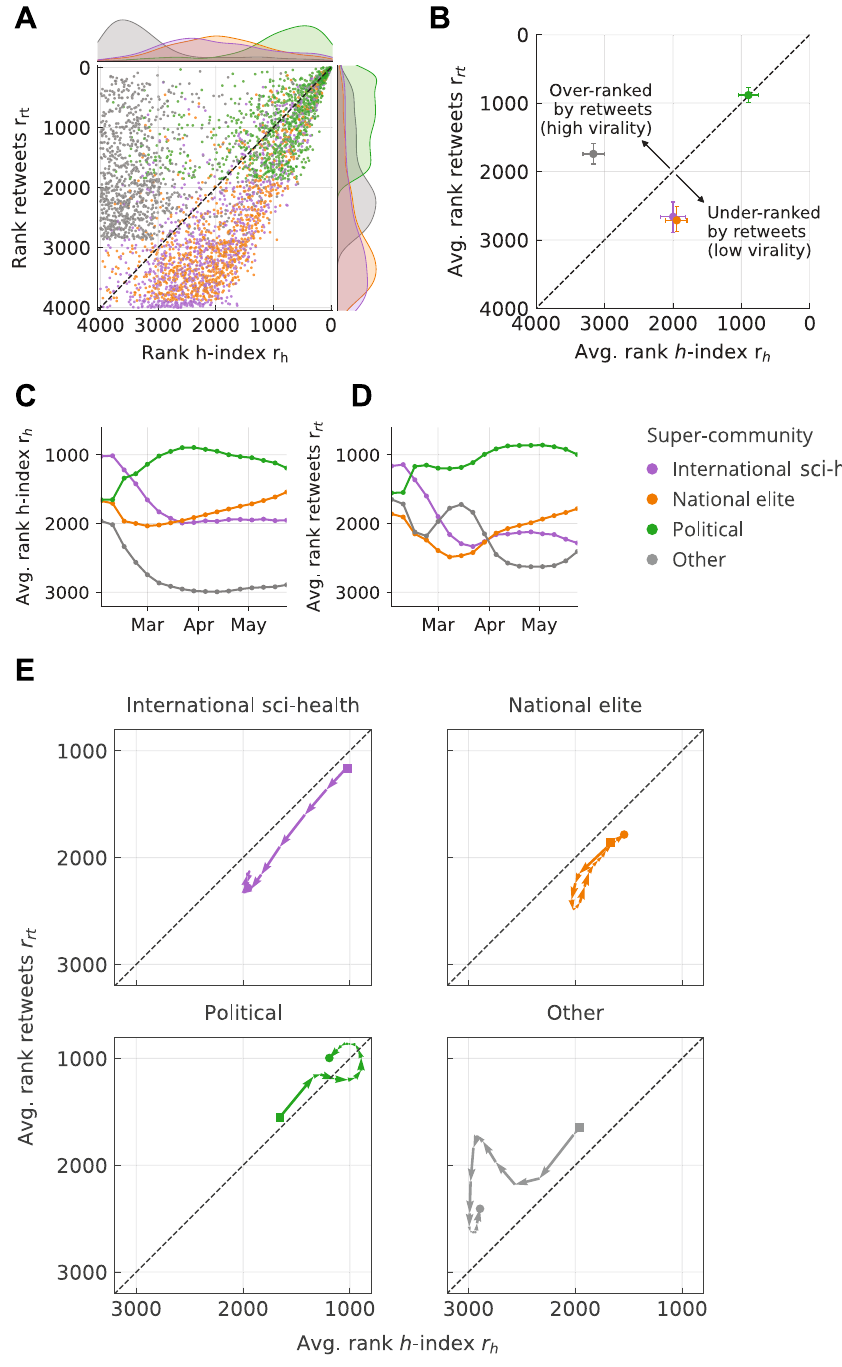
Figure 5. Static and temporal communication patterns of the top 1000 users of each super-community. ( A ) Comparison between the rank in terms of h -index and retweets by user, as well as respective marginal distributions. ( B ) The average rank by super-community with bootstrapped 95% confidence intervals. ( C ) Weekly h -index rank computed within a rolling time window of 1 month. ( D ) Weekly rank in retweets computed within a rolling time window of 1 month. ( E ) Vector plot of retweet and h -index ranks by super- community. Each arrow denotes the change in ranks within one week. The first and last week are marked with a square and circle,